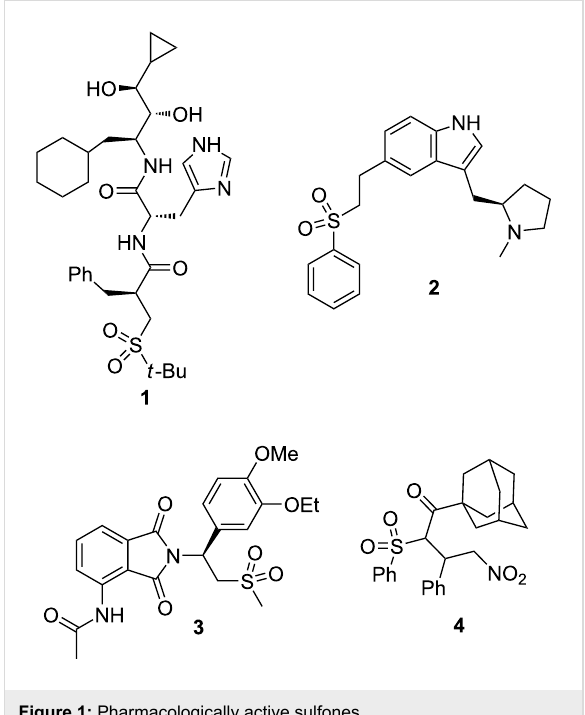
Figure 1: Р harmacologically active sulfones.